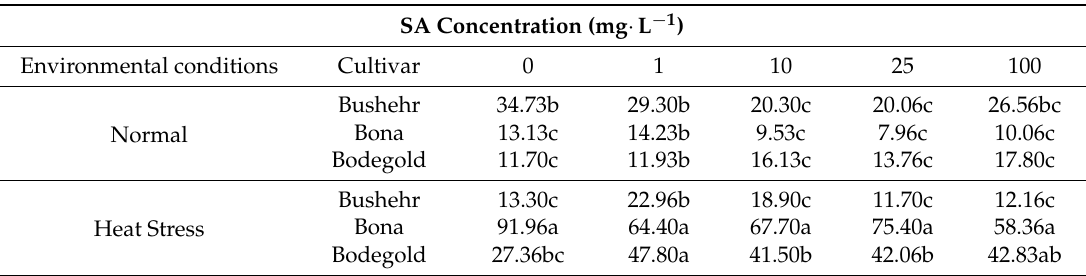
Table 10. Mean comparison of the interaction of environmental conditions ˆ cultivar ˆ salicylic acid on proline content according to ( µ mol/g ¨ dw) of